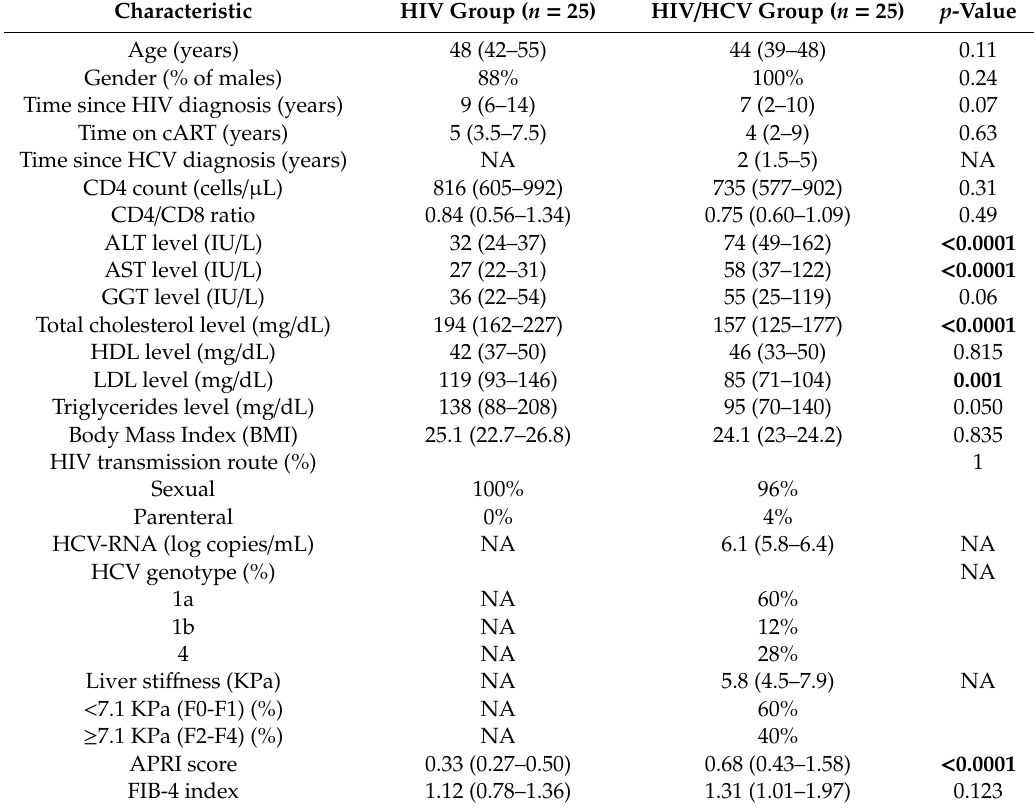
Table 1. Characteristics at baseline of patients included in the